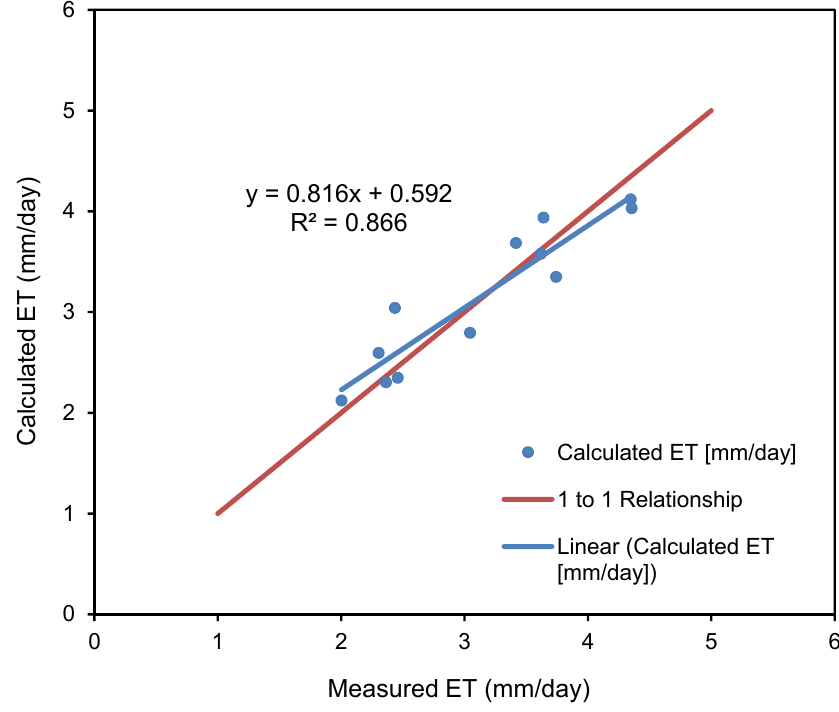
Figure 2. ET Comparison of Blaney and Criddle Calculated vs. Experimentally Determined from Hardin